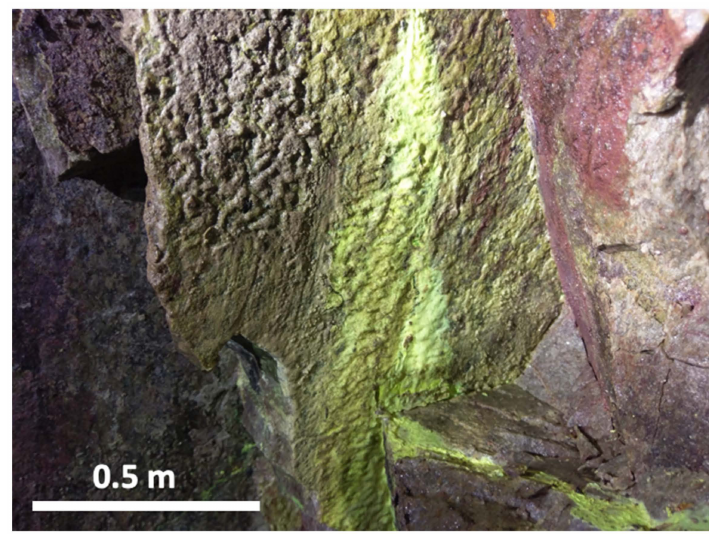
Figure 17. Example of second paragenesis from Podg ó rze